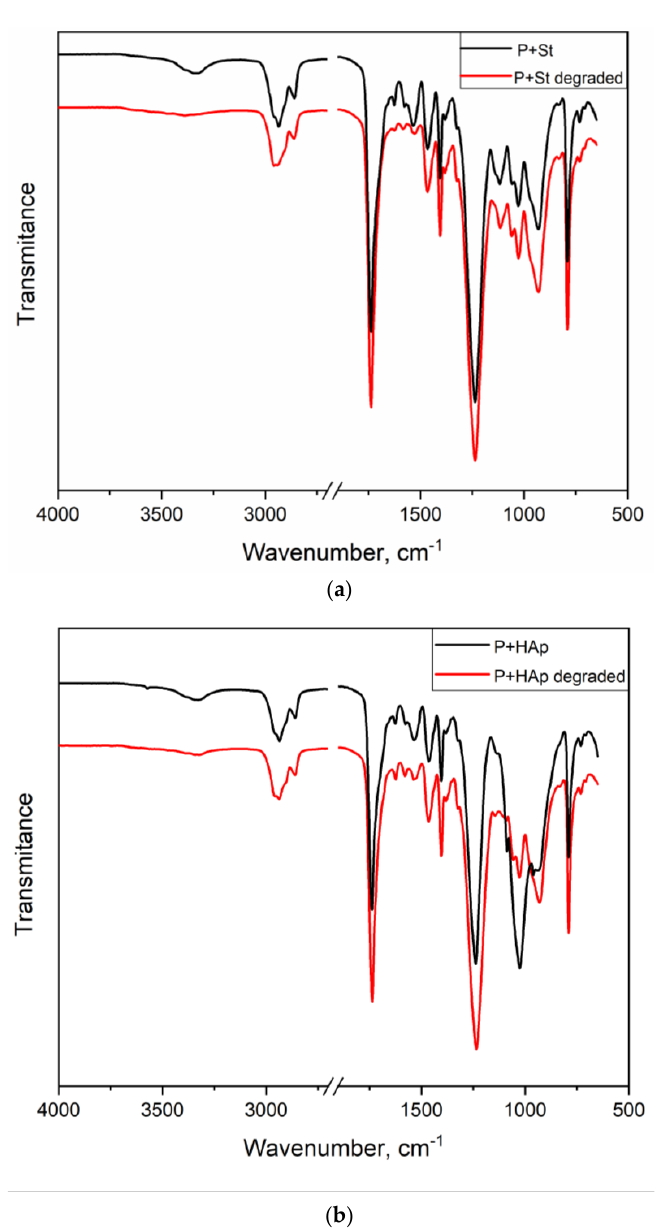
Figure 9. Comparison of the FTIR spectra of the P + St ( a ) and P + HAp ( b ) films before (red) and after 21 days of degradation (black).